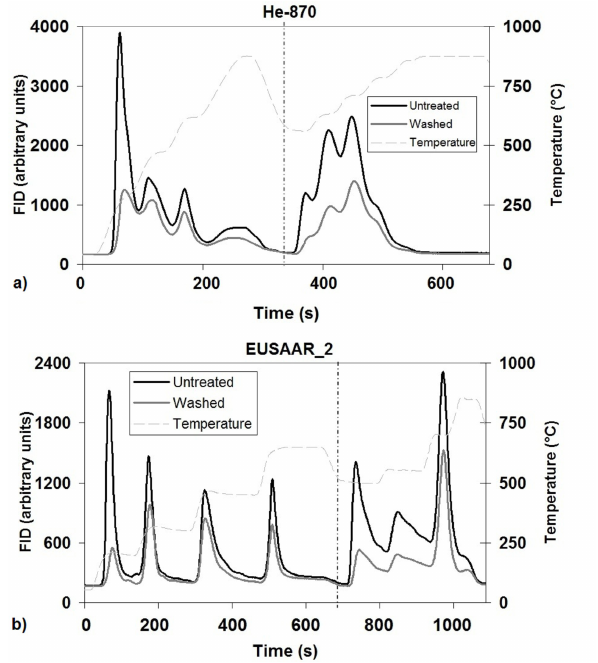
Fig. 6. Comparison between thermograms obtained analysing un- treated and washed samples with the He-870 (a) and EUSAAR 2 (b)